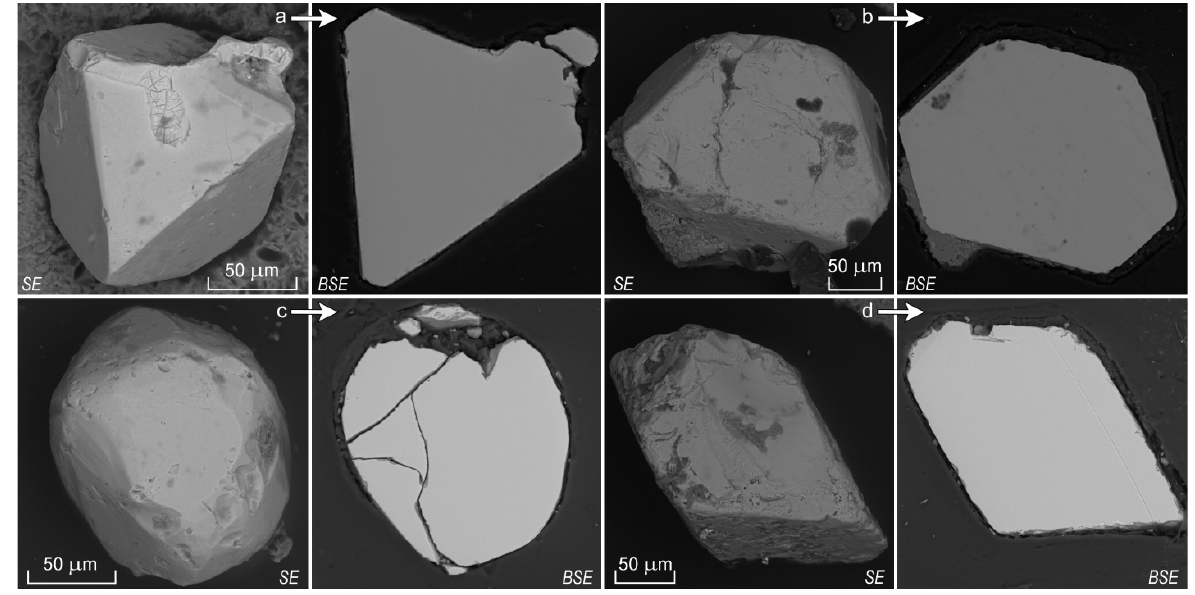
Figure 5. Morphology of chromian spinel grains from the Sabantuy paleoplacer (before grinding/after grinding): ( a )—octahedral crystal with outgrowth (group I), ( b )—flattened octahedral crystal (group II), ( c )—myriohedral crystal (group III), ( d )—rhombohedron-shaped crystal (group IV).